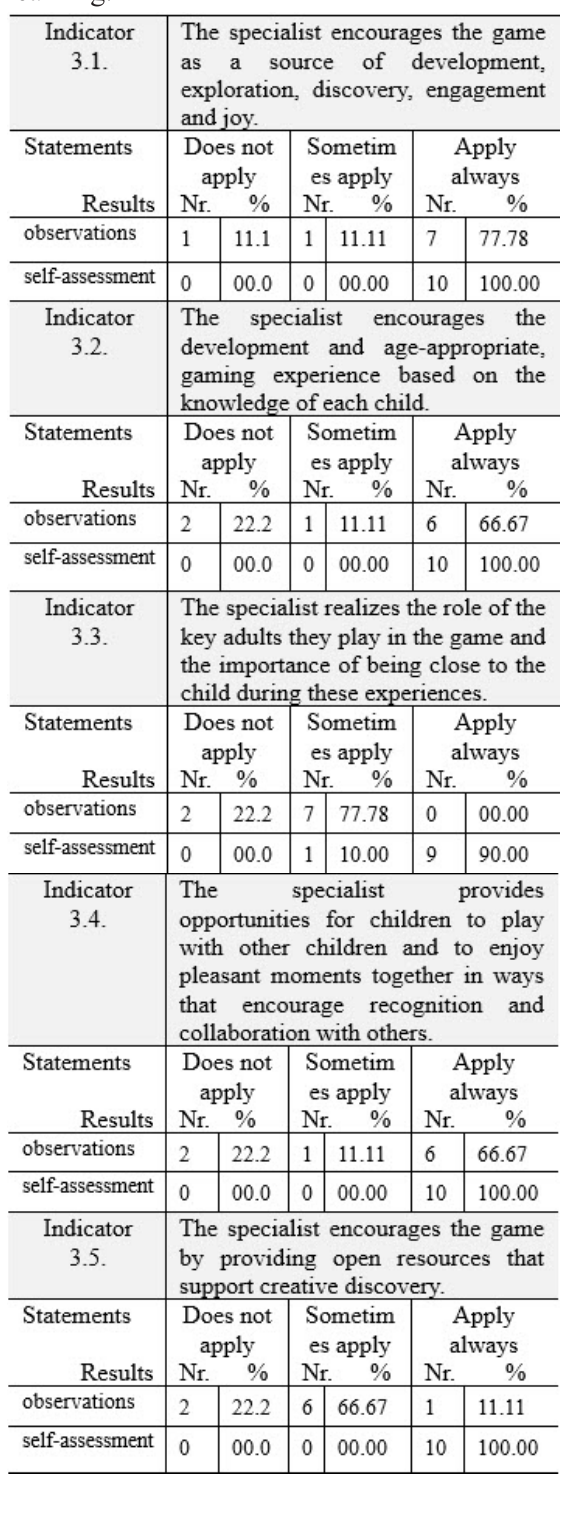
Table 20. Principle 3: Play is a source and strategy for development, well-being and learning.